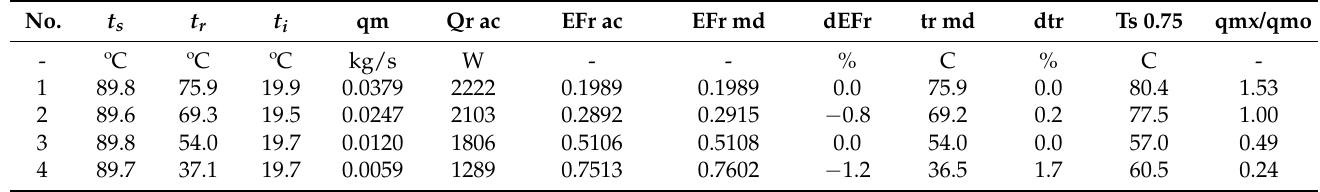
Table 4. The comparison between the measurement and the calculations results Radiator Delonghi 22 , t s = 89.8 ◦ C.